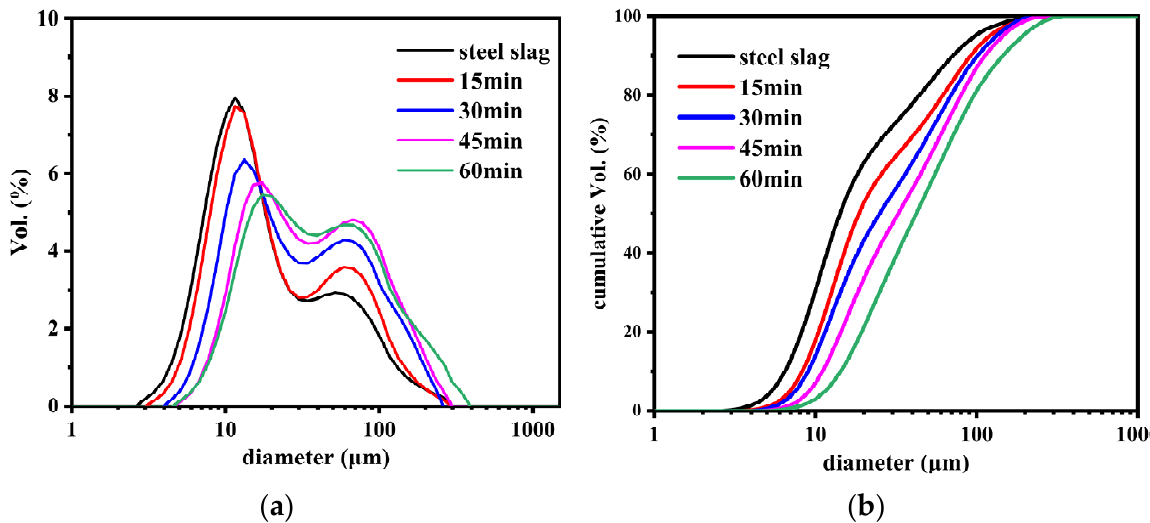
Figure 5. The particle size distribution ( a ) and cumulative size distribution ( b ) of SS@CNTs synthe- sized using different time intervals. Table 3. The BET surface areas and porosity characters of SS@CNTs synthesized using different time intervals.